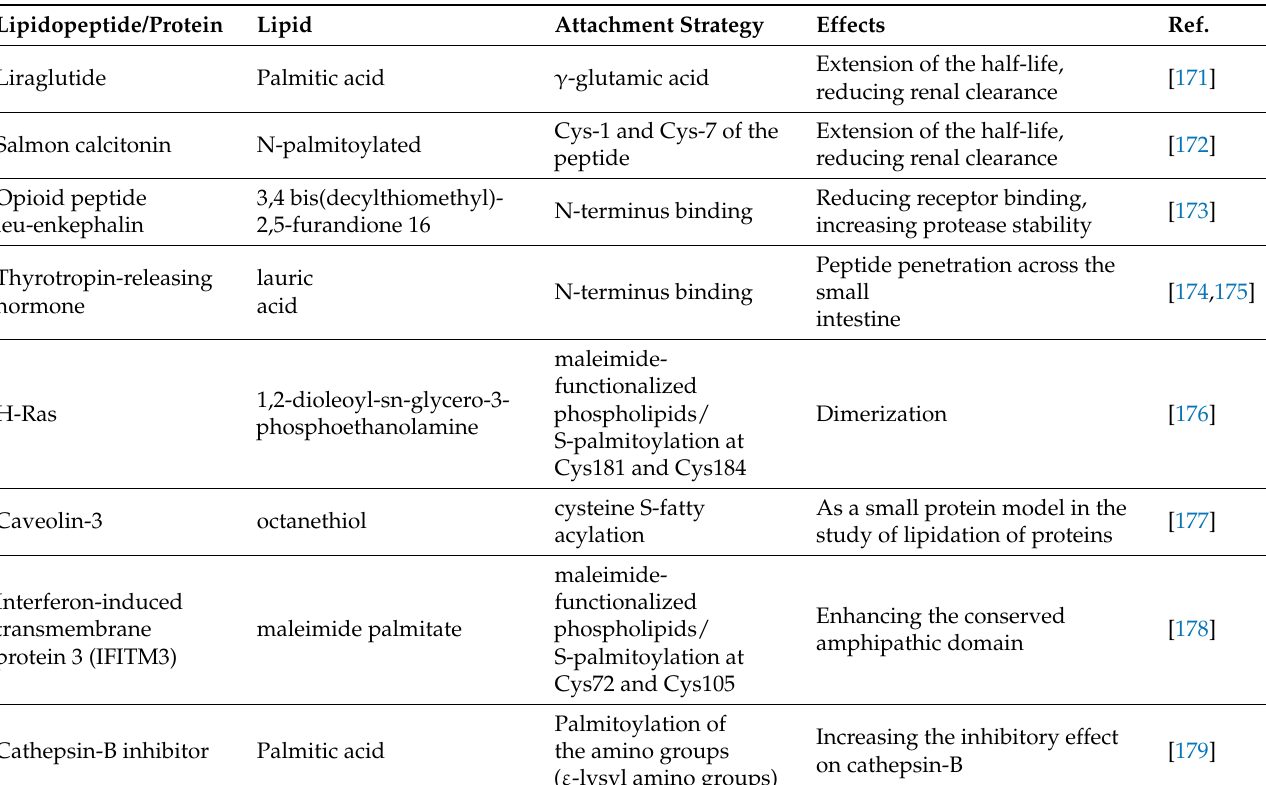
Table 3. The list of some peptide-lipid